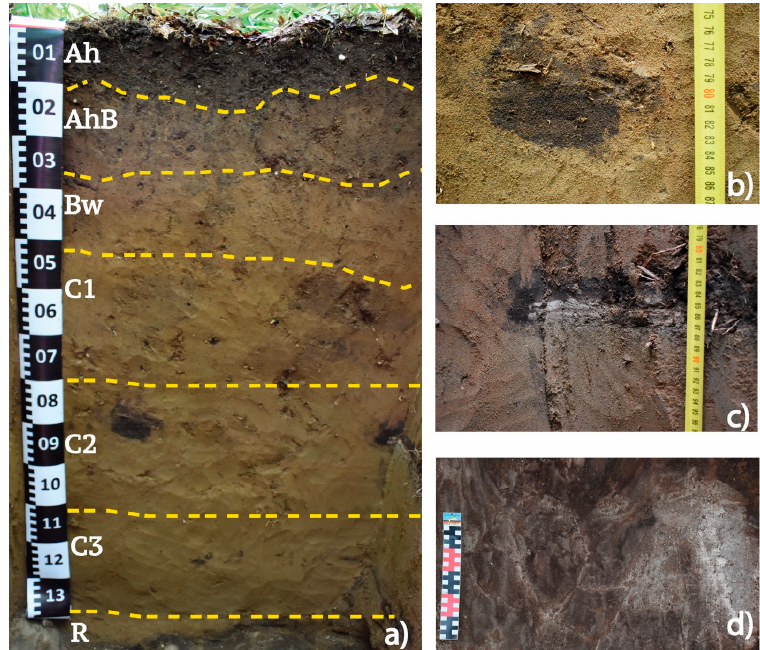
Figure 3. The surface soil ( Folic Eutric Cambisol ). ( a ) general view of the surface soil profile; ( b ) strongly weathered sandstone fragment that appear as very dark large spot in the C2 horizon; ( c ) weathered sandstone fragment with accumulation of dark-colored compounds translocated from the upper soil horizons; ( d ) consolidated calcareous sandstone plate (the view of from above, note dark coatings on the whitish surface of the unaltered